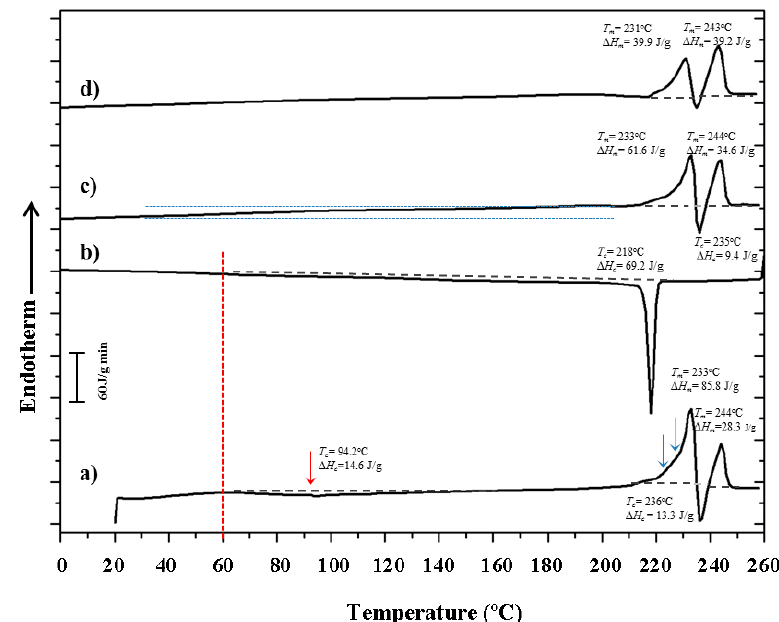
Figure 14. ( a ) Heating run of the as-synthesized nylon 4 9; ( b ) cooling run of nylon 4 9 from the melt state; ( c ) subsequent heating run of the melt crystallized sample; and ( d ) heating run from a nylon 4 9 melt quenched sample. Arrows indicate small endothermic and exothermic peaks.